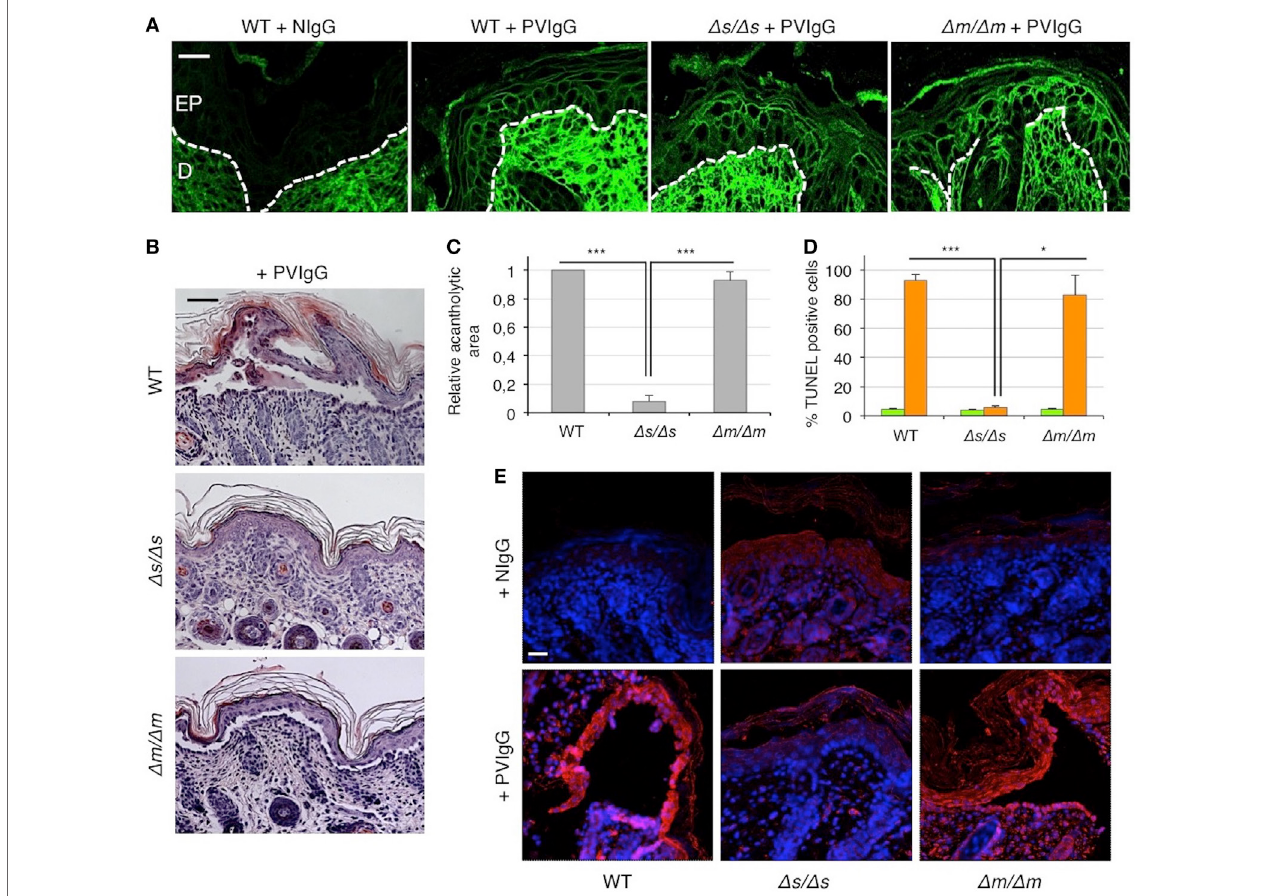
FigUre 4 | Blister formation is blocked in mice selectively lacking soluble Fas ligand (FasL). Wild-type (WT), FasL Δ s/ Δ s , and FasL Δ m/ Δ m mice were each injected with either normal human IgG (NIgG) or with pemphigus autoantibodies (PVIgG) and sacrificed at 20 h after injection. FasL Δ s/ Δ s : mice selectively lacking the soluble FasL; FasL Δ m/ Δ m : mice selectively lacking the membrane-bound FasL. (a) Representative images of PVIgG binding at the inter-keratinocyte level in the indicated mouse strains. Direct immunofluorescence: mouse skin specimens were challenged against fluorescein-conjugated human IgG. EP, Epidermis; D, dermis. Scale bar = 100 µm. NIgG (normal IgG) used as a negative control. (B) Representative hematoxylin and eosin staining of mouse skin. Scale bar = 75 µm. (c) Relative acantholytic areas in mouse skin (means ± SEM; *** P < 0.001 per one-way ANOVA; n = 10–11 mice/strain). (D) The percentage of TUNEL-positive cells in mouse skin treated either with NIgG (green bars) or with PVIgG (orange bars) (means ± SEM; * P < 0.05; *** P < 0.001 per one-way ANOVA; n = 10–11 mice/strain). (e) A representative immunofluorescence image showing active caspase-8 (red) expression at the skin level of NIgG or PVIgG-treated mice. Nuclei are shown in blue (DAPI). Scale bar = 100